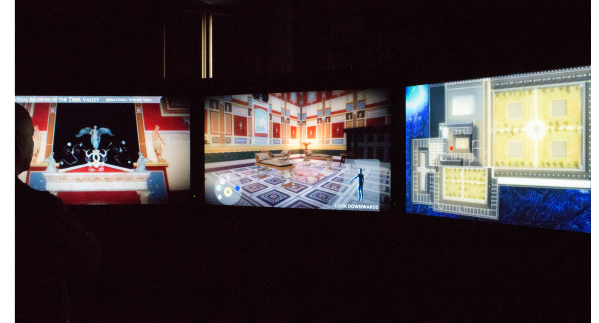
Figure 2. Virtual Museum of the Tiber Valley : aerial scenario 2. “ In the setting of the sun the Tiber gleams. The secrets of the